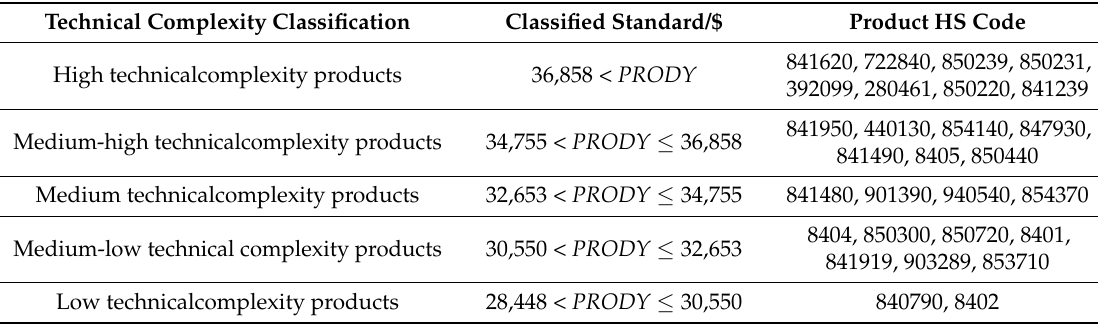
Table 2. The technology structure distribution of the world’s REPs.